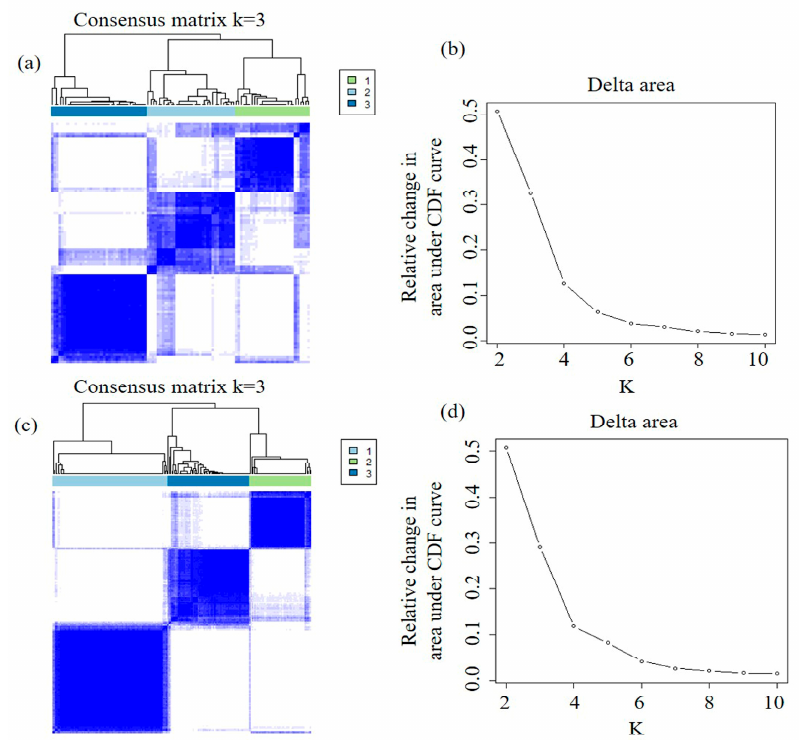
Figure 2. Feature extraction of pathological images. ( a ) For the whole tumor area, morphology, histogram, and texture features of the tumor nuclei are calculated. ( b ) For tumor core and tumor periphery, several types of features, including the density, spatial distribution, and relation between tumor cells and lymphocytes, are calculated. In particular, we evaluate the statistical features of the number of lymphocytes surrounding each tumor cell. Red, green, blue outlines for individual nuclei correspond to those of tumor cells, lymphocytes, and other cells, respectively. The magnification for all images is 40 × .